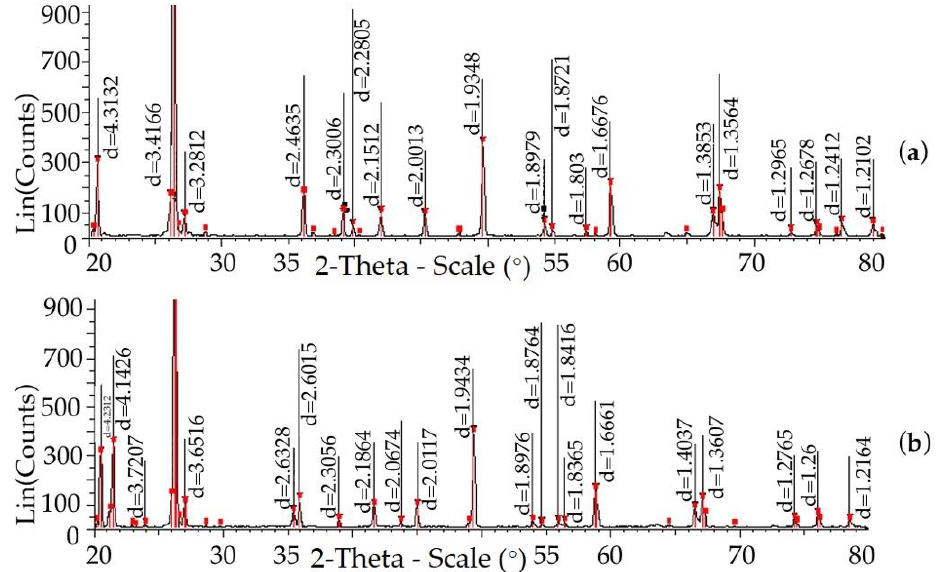
Figure 6. The X-ray diffraction patterns of quartzite: ( a ) obtained at 600 °C; ( b ) obtained at 1550 °C.